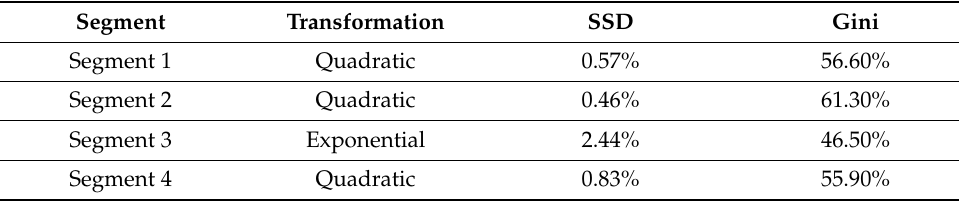
Table 5. 12 month Lorenz curve calibration statistics.